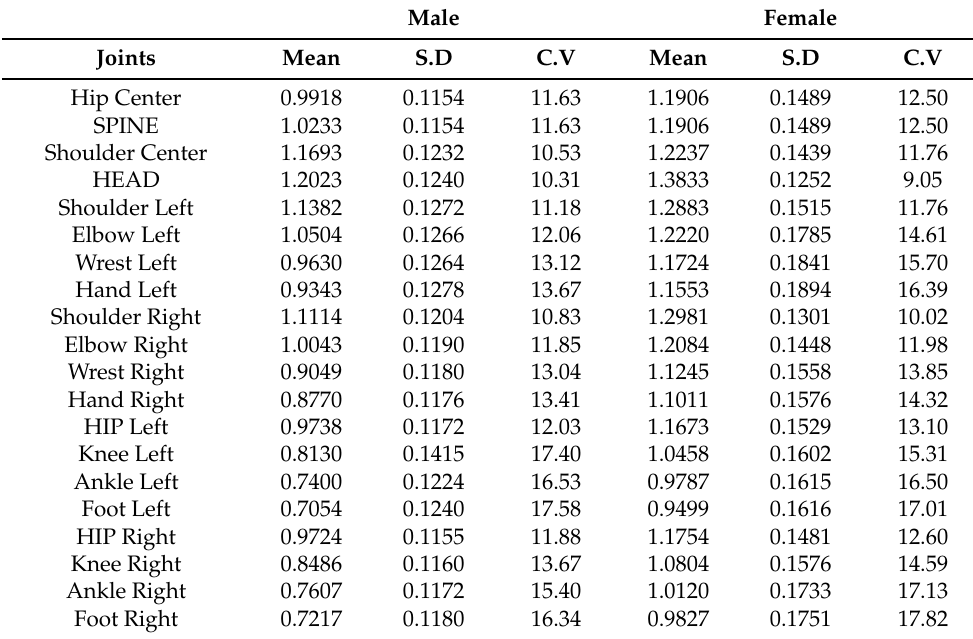
Table 1. The mean, standard deviation (S.D), and coefficient of variation (C.V) for various joints of male and